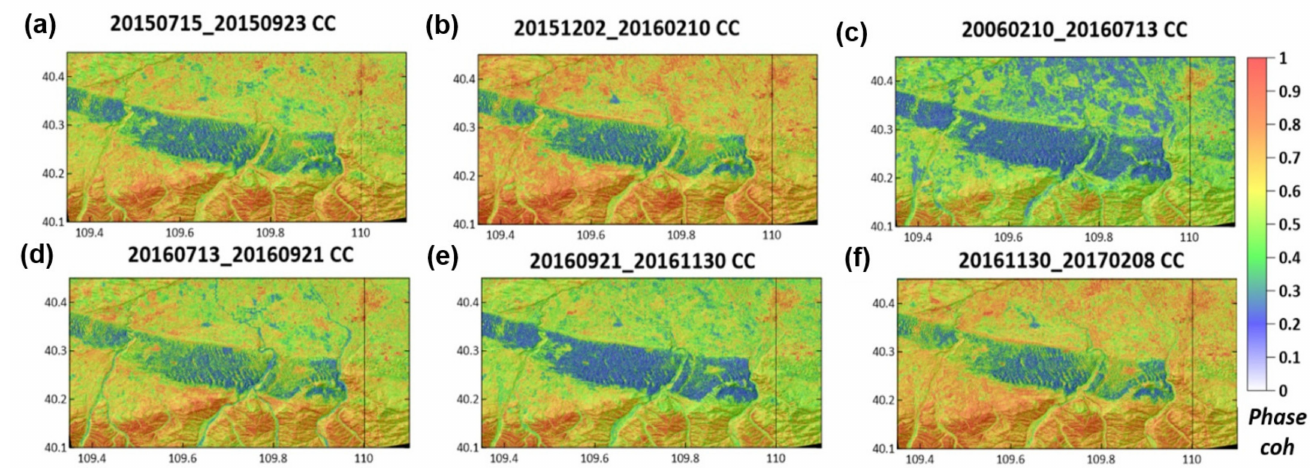
Figure 4. InSAR phase coherence using PALSAR-2, including pairs of ( a ) 15 July 2015–23 September 2015, ( b ) 2 December